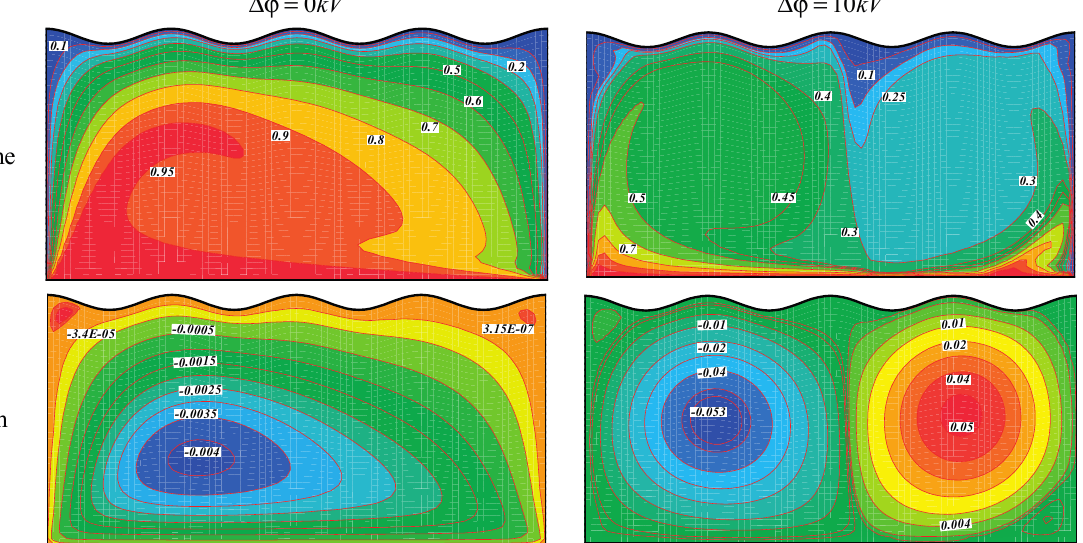
Figure 4. Effect of supplied voltage on streamlines and isotherm when 3000, 0.04 Re = φ =